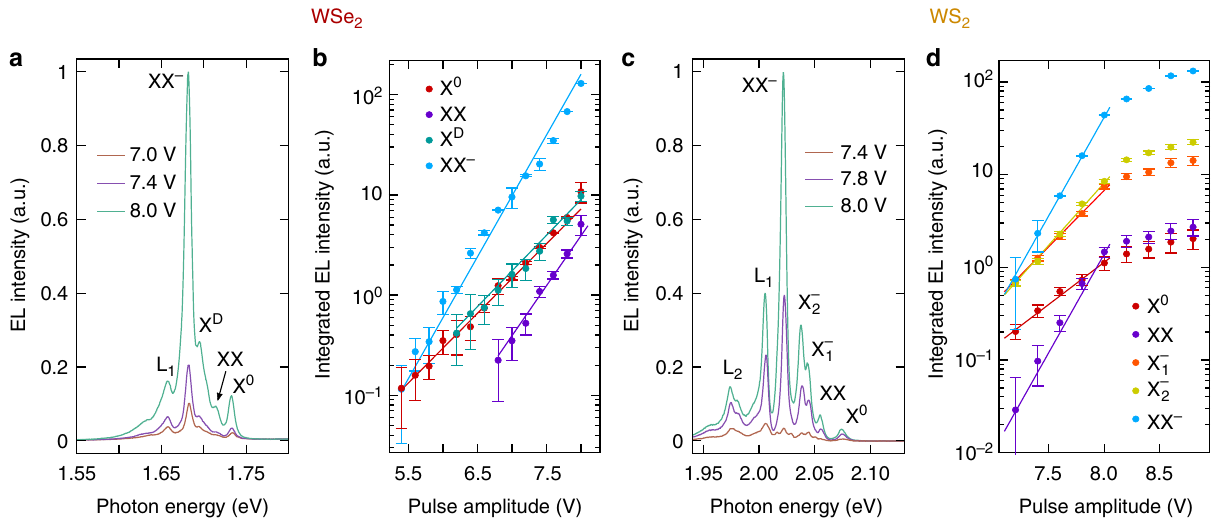
Fig. 3 EL intensity dependence with the excitation power. a Pulsed EL emission spectra of WSe 2 for different pulse amplitudes and fi xed offset voltage. b Semi-logarithmic plot of the integrated EL intensity as a function of the pulse amplitude. The circles represent the experimental data, while the lines depict the fi t to an exponential function as discussed in the main text. c , d Same as in a , b but for WS